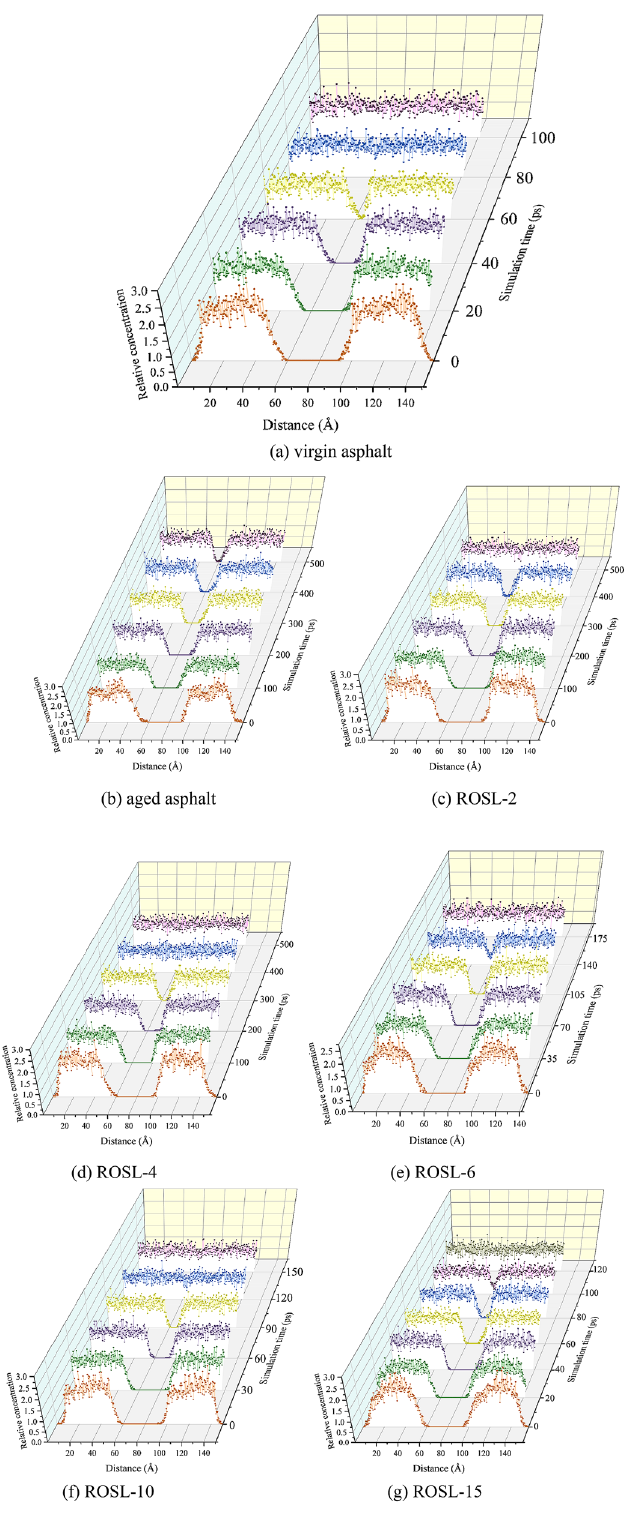
Figure 5. Molecular relative concentration of the asphalts MD model in the OZ